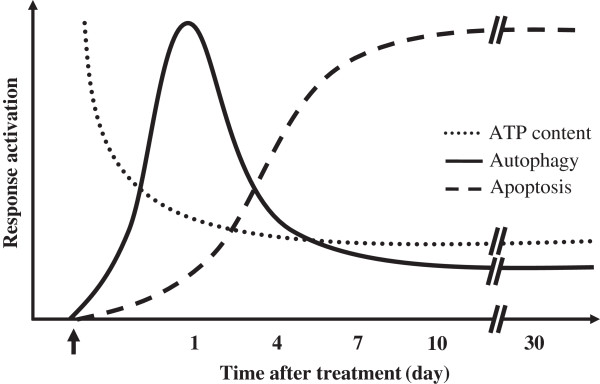
Interrelationship among changes in ATP content, autophagy, and apoptosis in rat livers after Ag-nps administration. This figure was constructed using data from Figures 4, 5, and 6.